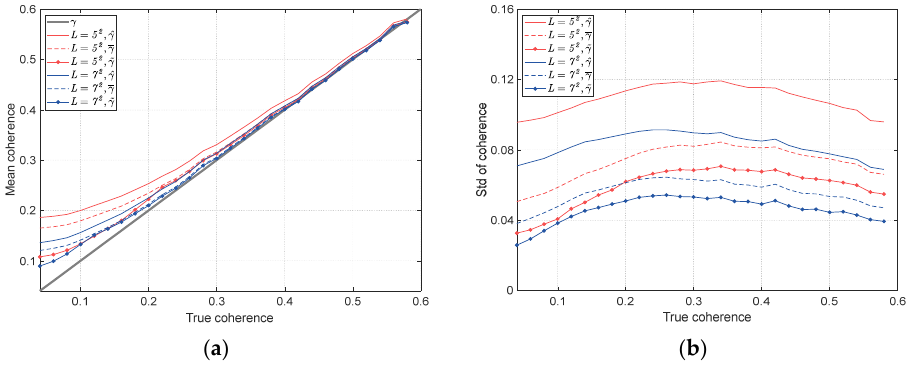
Figure 7. ( a ) Means and ( b ) standard deviations for different coherence magnitude estimators using different numbers of